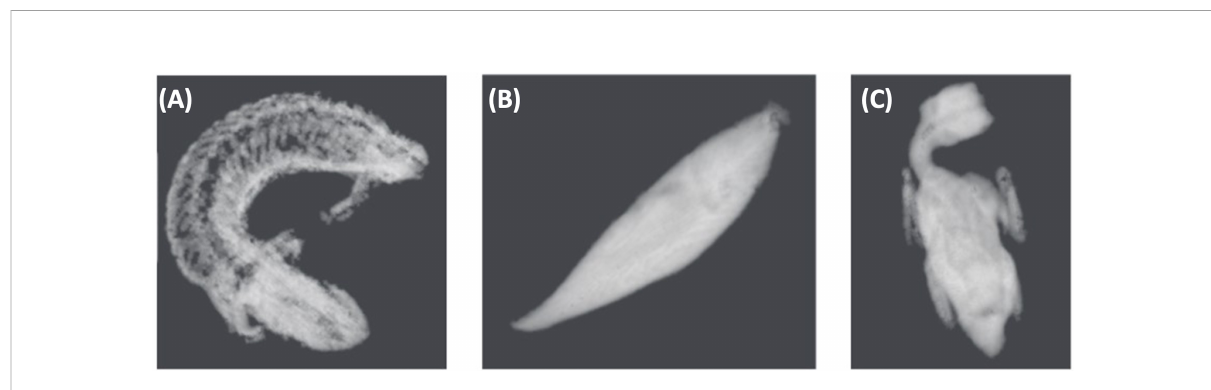
FIGURE 4 Grayscale image examples of three different species used in algorithm development. This includes (A) Shingleback lizard ( Tiliqua rugosa ), (B) Eastern school whiting ( Sillago fl indersi ) and (C) Rainbow lorikeet parrot ( Trichoglossus moluccanus ). These images are a result of algorithm training using Real Time Tomography technology to produce 3D volume data.